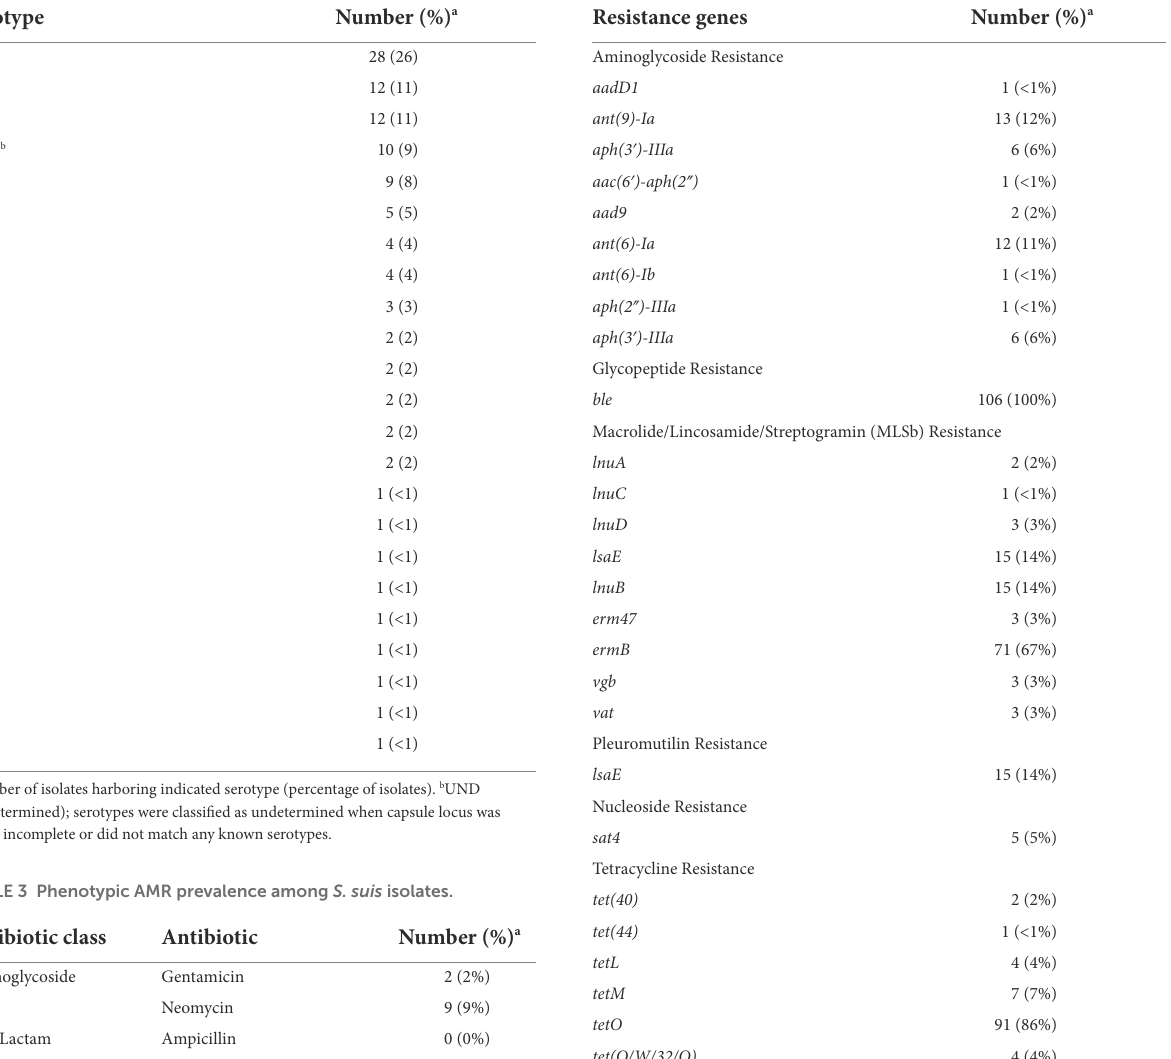
TABLE 4 AMR elements